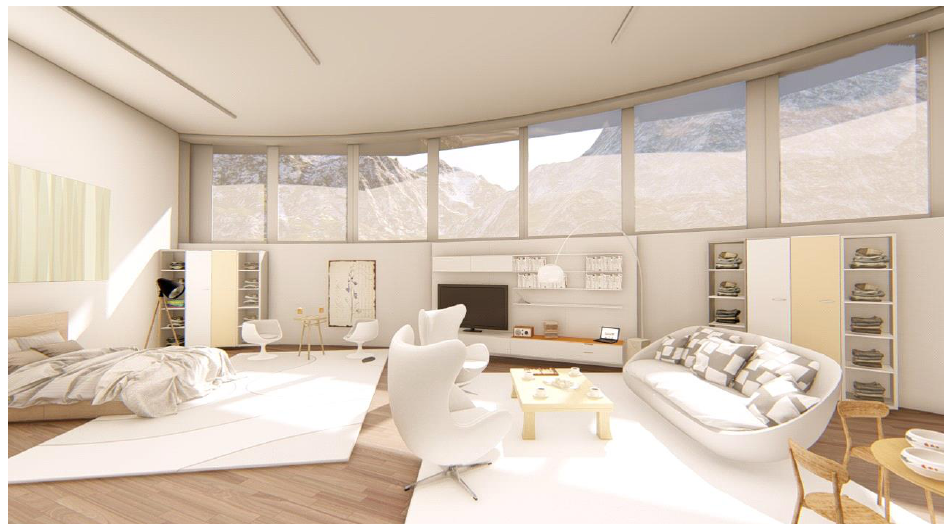
Figure 44. Interior of tourist unit. In the interior again, as in ancient times, there is a common zone, a place where visitors spend time together, just like our ancestors. There is everything needed in it. Only the bathroom, located next to the entrance to the unit, is separated. The windows bring a lot of light into the unit and invite tourists to spend their time primarily in nature, outdoors, to enjoy it and thus improve their health. Lepenski Vir, Serbia (2019) by ArhiArhi (Predrag, Vladimir and Grigor